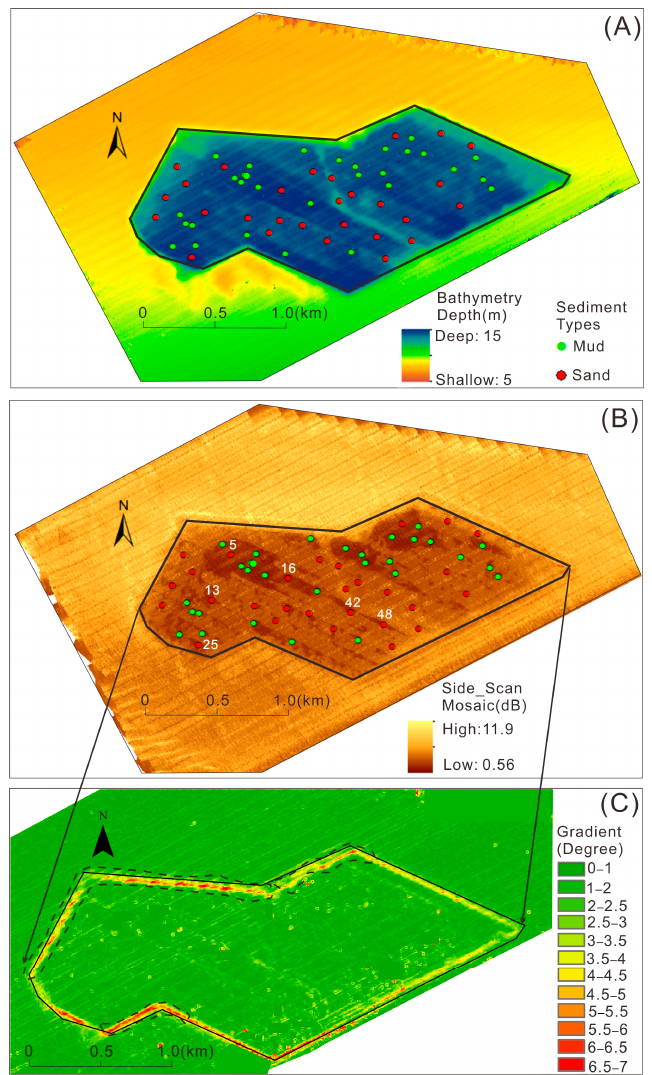
Figure 2. ( A ) Bathymetry map in a survey from August 2018 with 1-m horizontal resolution. The depth value is positive with a unit of meter. ( B ) Side-scan map of Caminada pit in August 2018 with 10-m resolution. Note that the dark brown indicates the patchy mud with low backscatter values, while the bright yellow is associated with sandy sediment with high backscatter values. ( C ) Gradient map of the Caminada pit derived from August 2018 bathymetry. Green colors represent flatter surfaces, while red colors indicate steeper ones. The dotted polygons are steep pit walls.